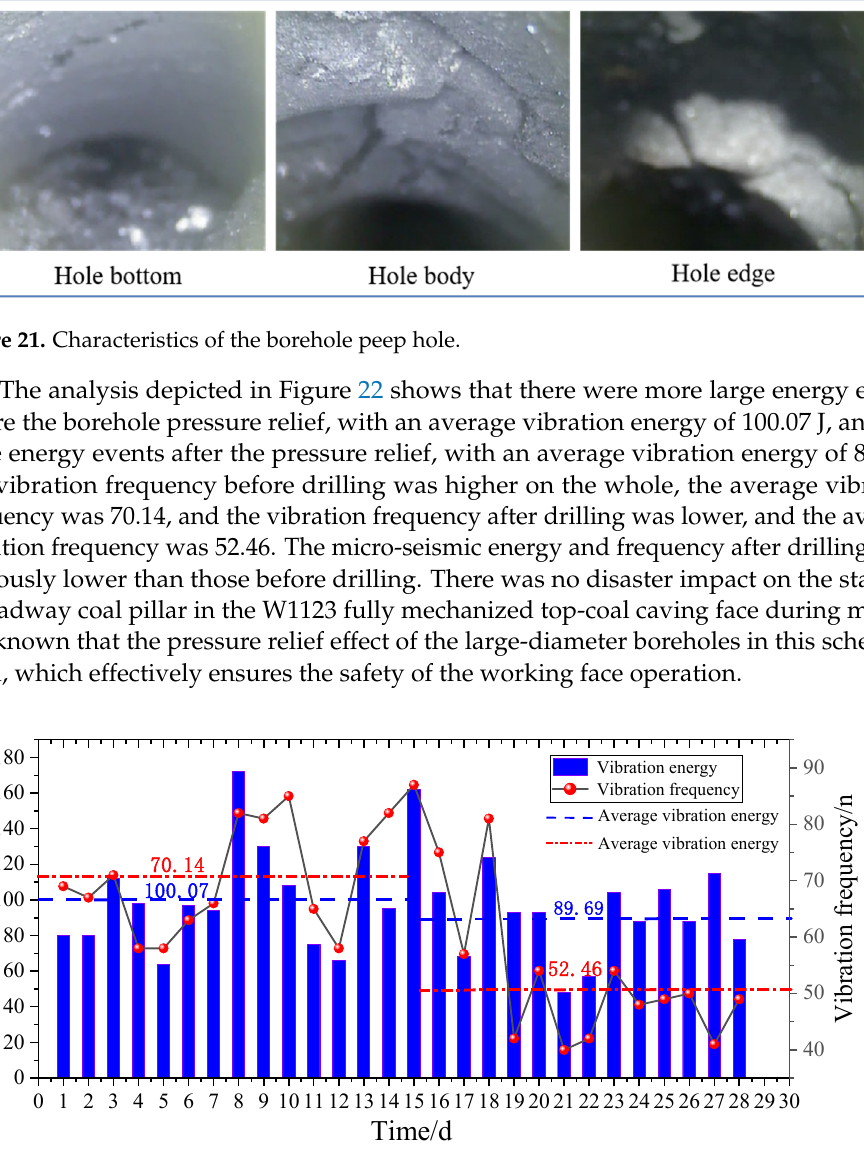
Figure 22. Comparison of energy-frequency characteristics before and after the pressure relief of the large-diameter borehole based on micro-seismic monitoring.